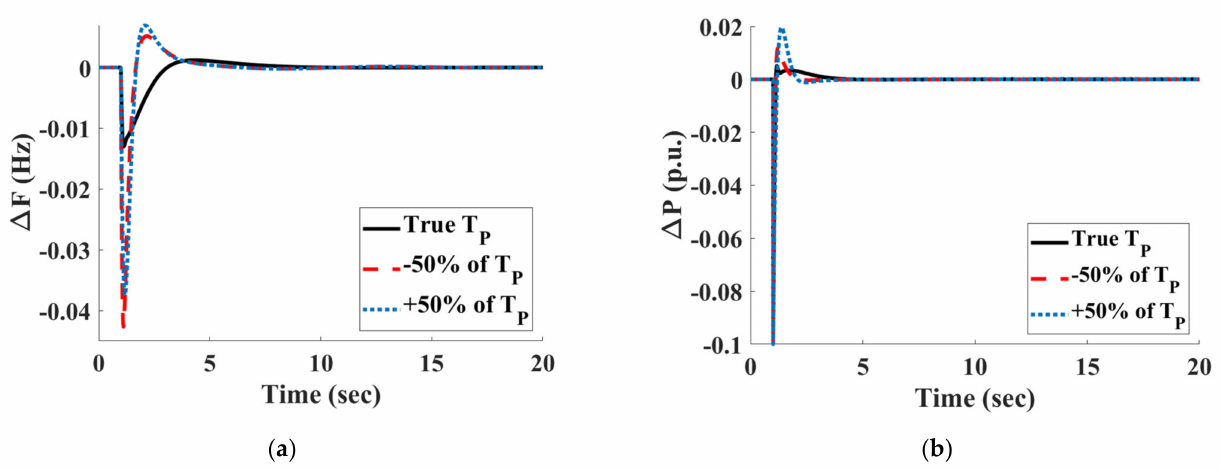
Figure 10. Sensitivity analysis of the HPSREG with the “PID-With-VI-FO-F-PID” configuration during ± 50% changes in T P : ( a ) ∆ F ( Hz ) and ( b ) ∆ P ( p . u . )